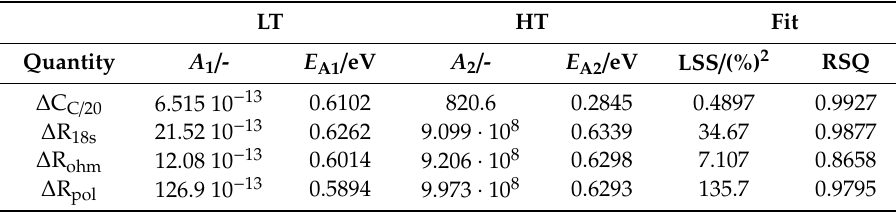
Table 2. Arrhenius fit coe ffi